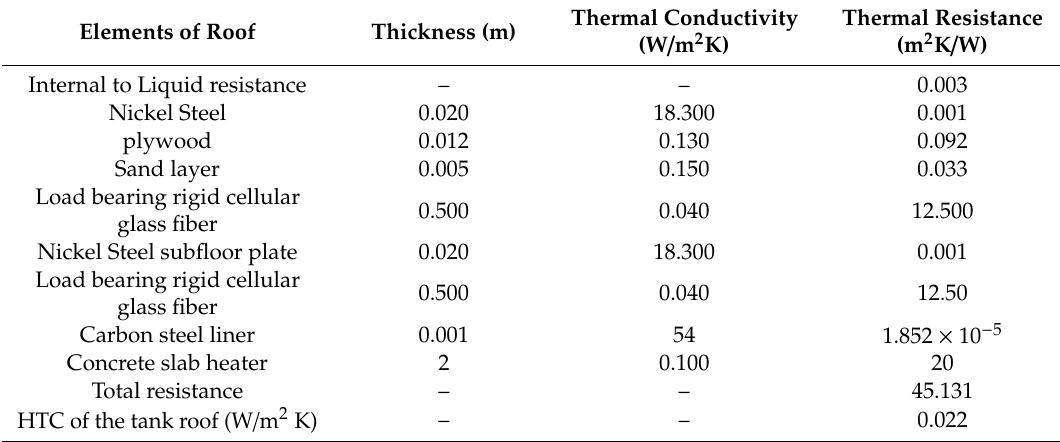
Table 4. Elements of LNG tank bottom